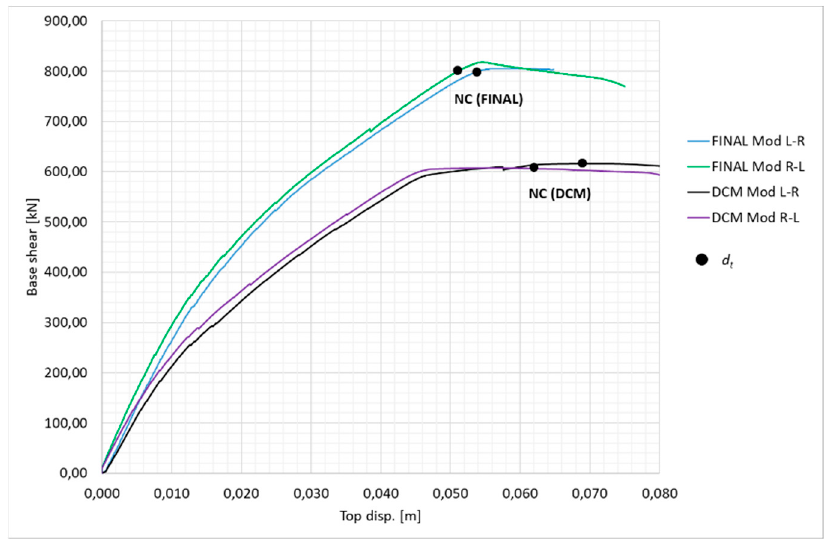
Figure 14. Capacity curves and performance points of the DCM and FINAL.